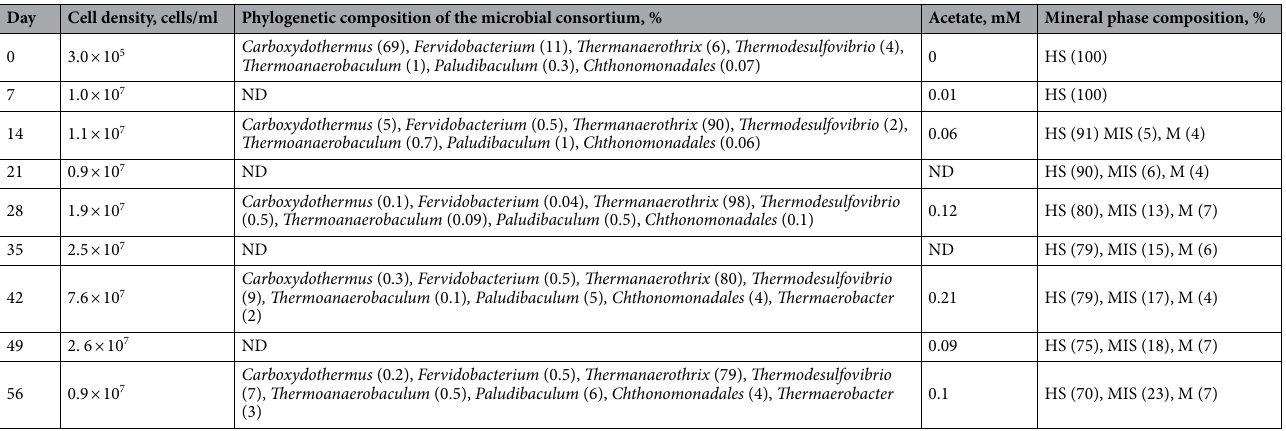
Table 1. Summarized parameters of the bioreactor culture for the 56-day incubation period. HS, hydrothermal siderite; MIS, metabolically induced siderite; M, magnetite; ND, not